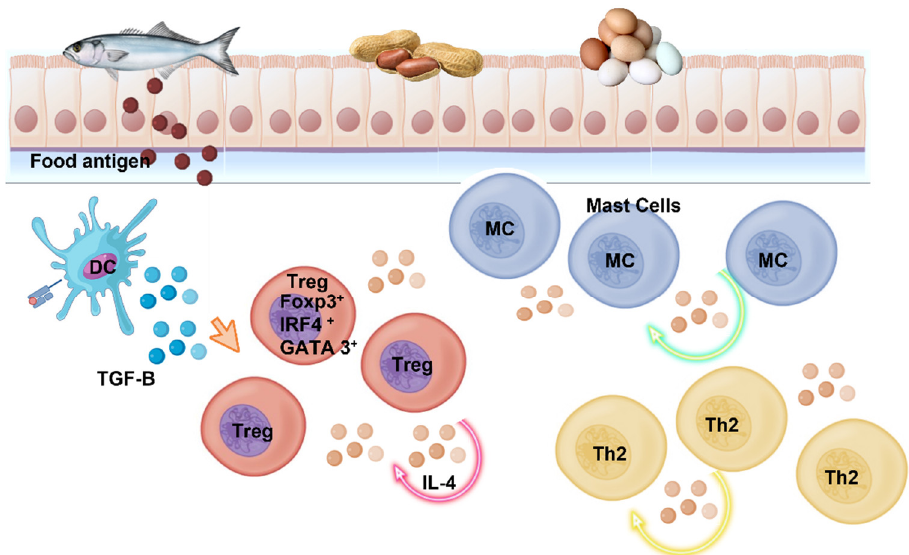
Figure 1. In patients suffering from FA, the Tregs in the gut mucosa can acquire a pathogenic, TH2 cell-like, phenotype. These pathogenic Tregs display high levels of GATA-3 and increased IL-4 production, resulting in the accumulation of dysfunctional antigen-specific Tregs, which fail to control effector TH2 and mast cell responses, promoting allergic disease. Th2 cells (yellow), Tregs cells (red), mast cells (blue).